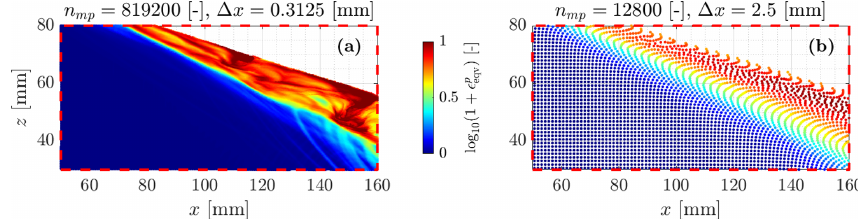
Figure 10. (a) (cid:15) p eqv for the zoomed-in area in Fig. 9. A shallow granular flow clearly appears, as suggested by the higher values of (cid:15) p eqv . This supports evidence of shallower granular avalanches during collapses. Deeper structures, which result in lower accumulated plastic strains, probably highlight slower deformation modes along well-defined and persistent shear bands. (b) (cid:15) p eqv for a coarser background mesh resolution, which demonstrates the influence of the mesh resolution over shear bands.